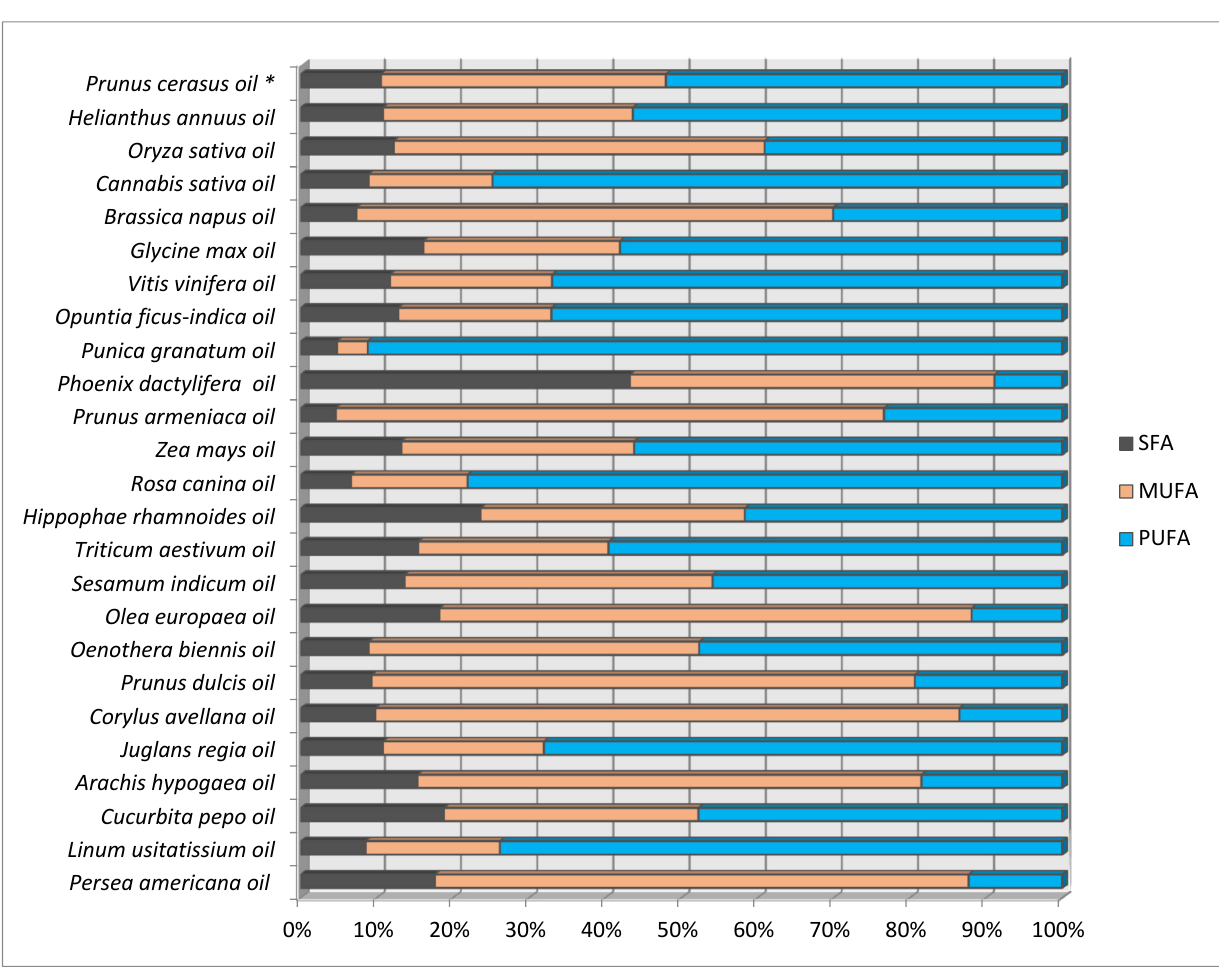
Figure 1. Saturated fatty acids (SFA), monounsaturated fatty acids (MUFA), and polyunsaturated fatty acids (PUFA) in sour cherry oils (mean for eight cultivars) in comparison with selected conventional plant oils. Source: * data obtained from our own research; all other data from literature [21–26]. Sour cherry kernel oil, with low content of saturated fatty acids and the high content of unsaturated fatty acids, is highly favourable in human nutrition and health. It is known that unsaturated fatty acids are of importance to the human body and skin health [19]. Mo- nounsaturated oleic acid with a number of potential health effects (including improvement the modulation of inflammatory markers) is a possible ingredient of functional foods